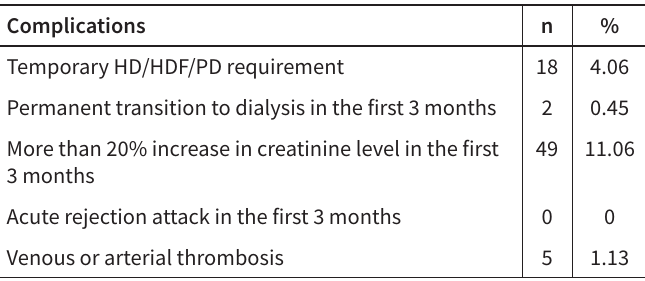
Table 4. Frequencies of Coronavirus Disease